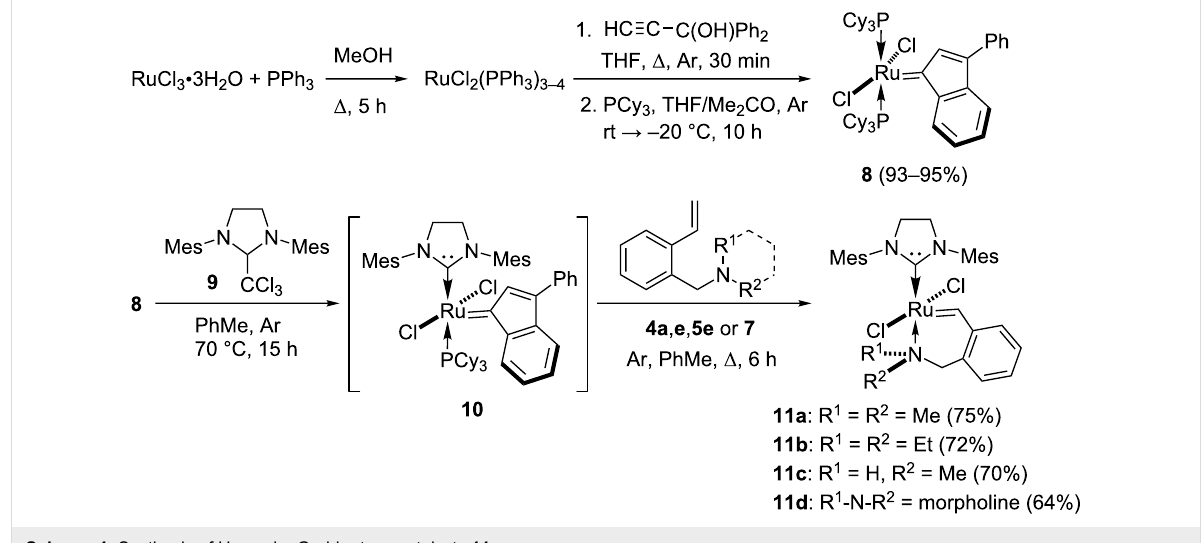
Scheme 4: Synthesis of Hoveyda–Grubbs-type catalysts 11 .